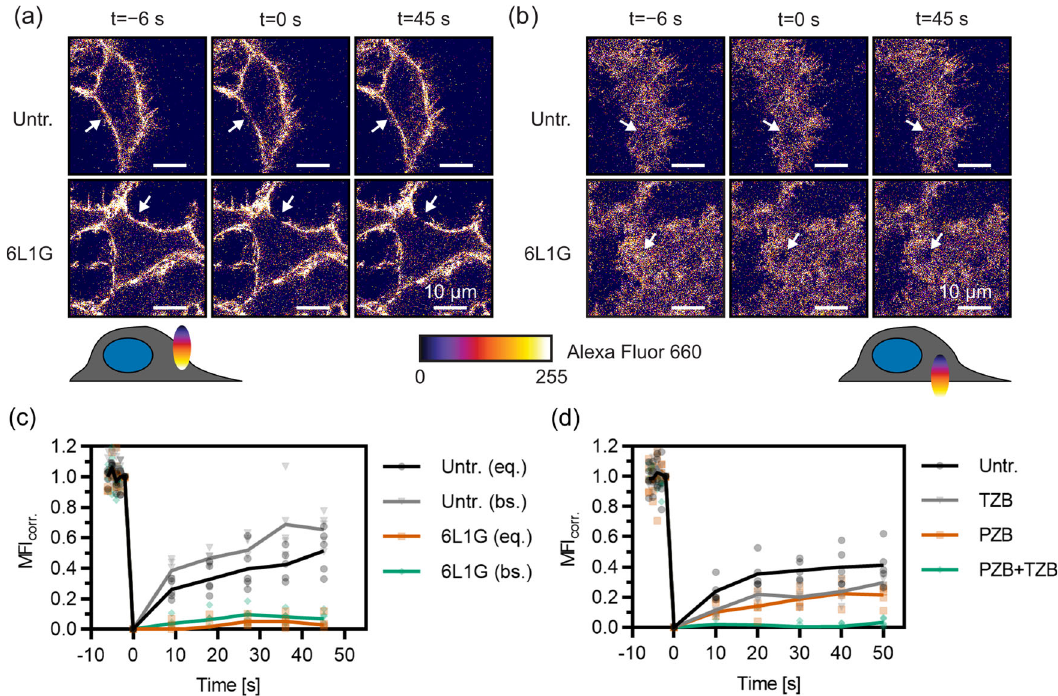
Fig. 3 Changes in the mobility of Halo-tagged HER2 on the surface of HEK293 cells upon treatment with DARPins and mAbs, quanti fi ed by FRAP. a , b Confocal images from a representative FRAP experiment of HT-HER2 labeled with Alexa Fluor 660, by photobleaching either a in the equatorial (eq.) or b basal (bs.) membrane plane. The arrow indicates the location of the bleach spot (2 µ m diameter). c , d FRAP curves (bleach-corrected, normalized mean fl uorescence intensities in the bleached ROI after subtraction of residual intensity at t = 0) for various DARPin and antibody treatments and controls. c Massive reduction of mobility upon treatment with DARPin 6L1G. Data from the basal membrane are shown in addition to those obtained by regular measurements in the equatorial plane. d Slight reduction in mobility is seen upon treatment with the therapeutic mAbs PZB and TZB individually but complete immobilization by their combination (PZB + TZB). Untr.,